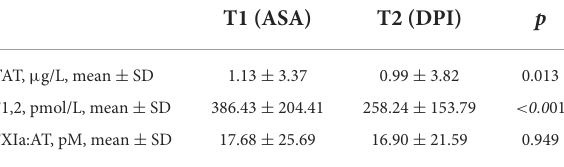
TABLE 4 The effect of DPI on activation of the common and intrinsic pathway of